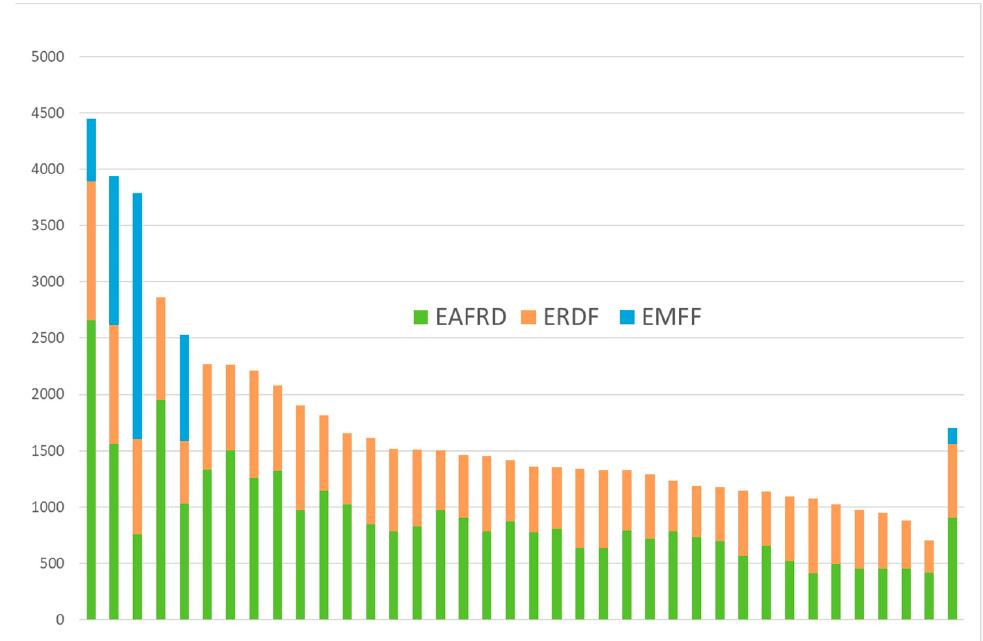
Figure 8. Budgets of the 37 multi-funded LAGs in Slovenia 2014–2020, by ESI fund, in EUR 1000 [9]; Data from Slovenian programme authorities. Note—country average on the right.